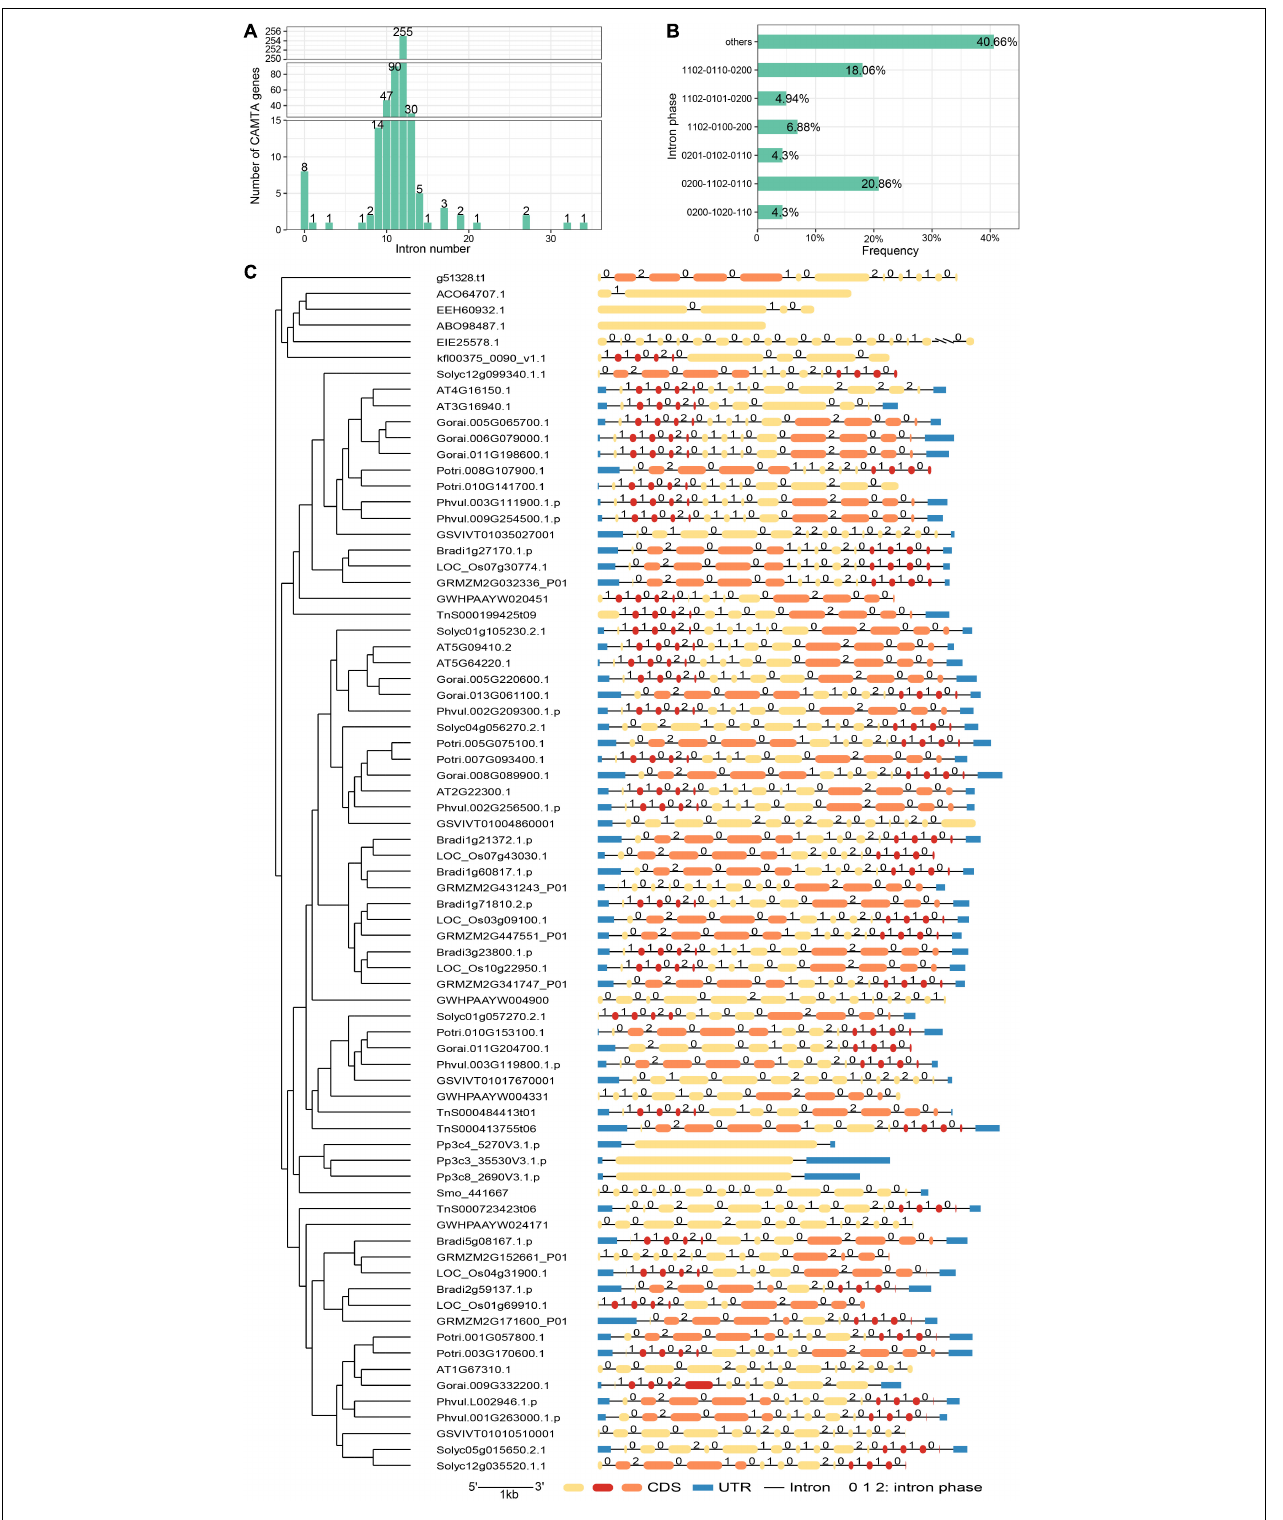
FIGURE 3 | Gene structure analysis of CAMTAs. (A) Distribution of intron number. (B) Percentage of intron phase. (C) CAMTA structures of some representative species. Pink indicates the exons corresponding to intron phase pattern 0200 and 0201, and dark red denotes those corresponding to intron phase pattern 1102 or